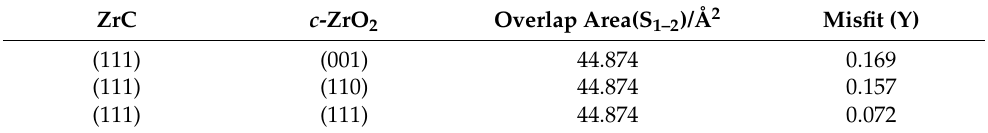
Table 1. Surface mismatch parameter Υ calculated for different combinations of ZrC and c -ZrO 2